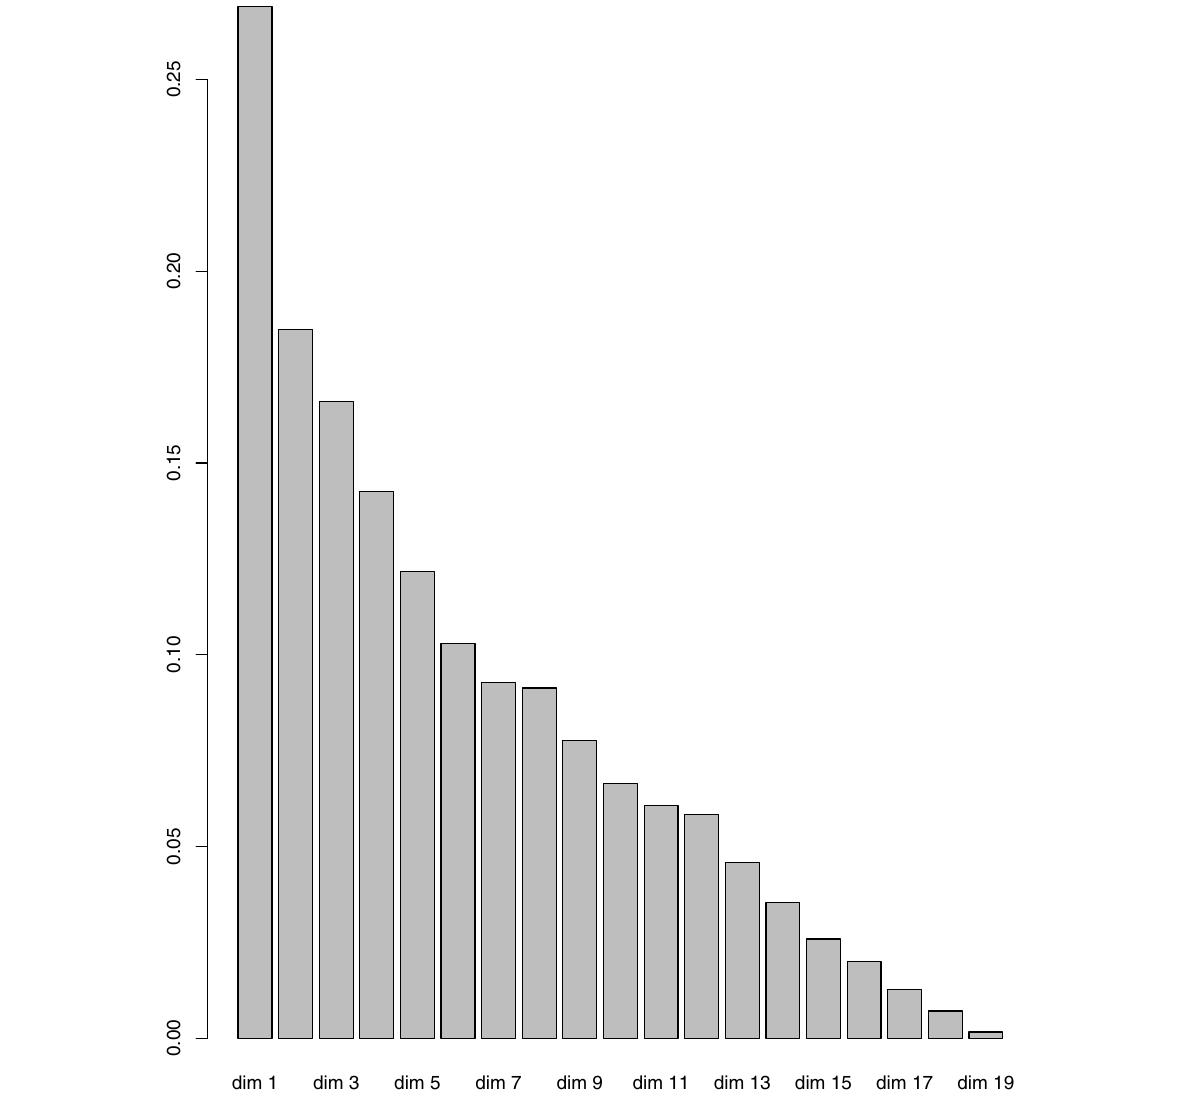
Fig. 1 Percentage of the contribution of each dimension to the total